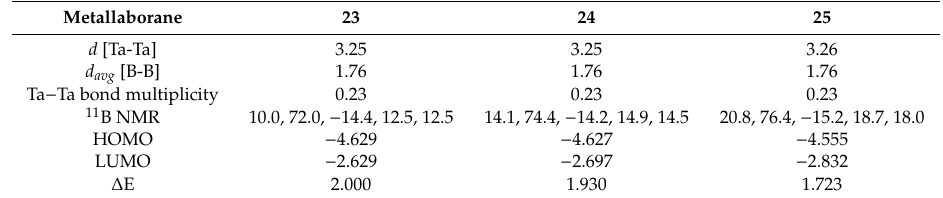
Table 5. Calculated bond length parameters (Å), Ta − Ta bond multiplicity, 11 B chemical shifts (ppm), HOMO and LUMO energy (eV), and HOMO-LUMO gaps ( ∆ E, eV) for 23 – 25 .